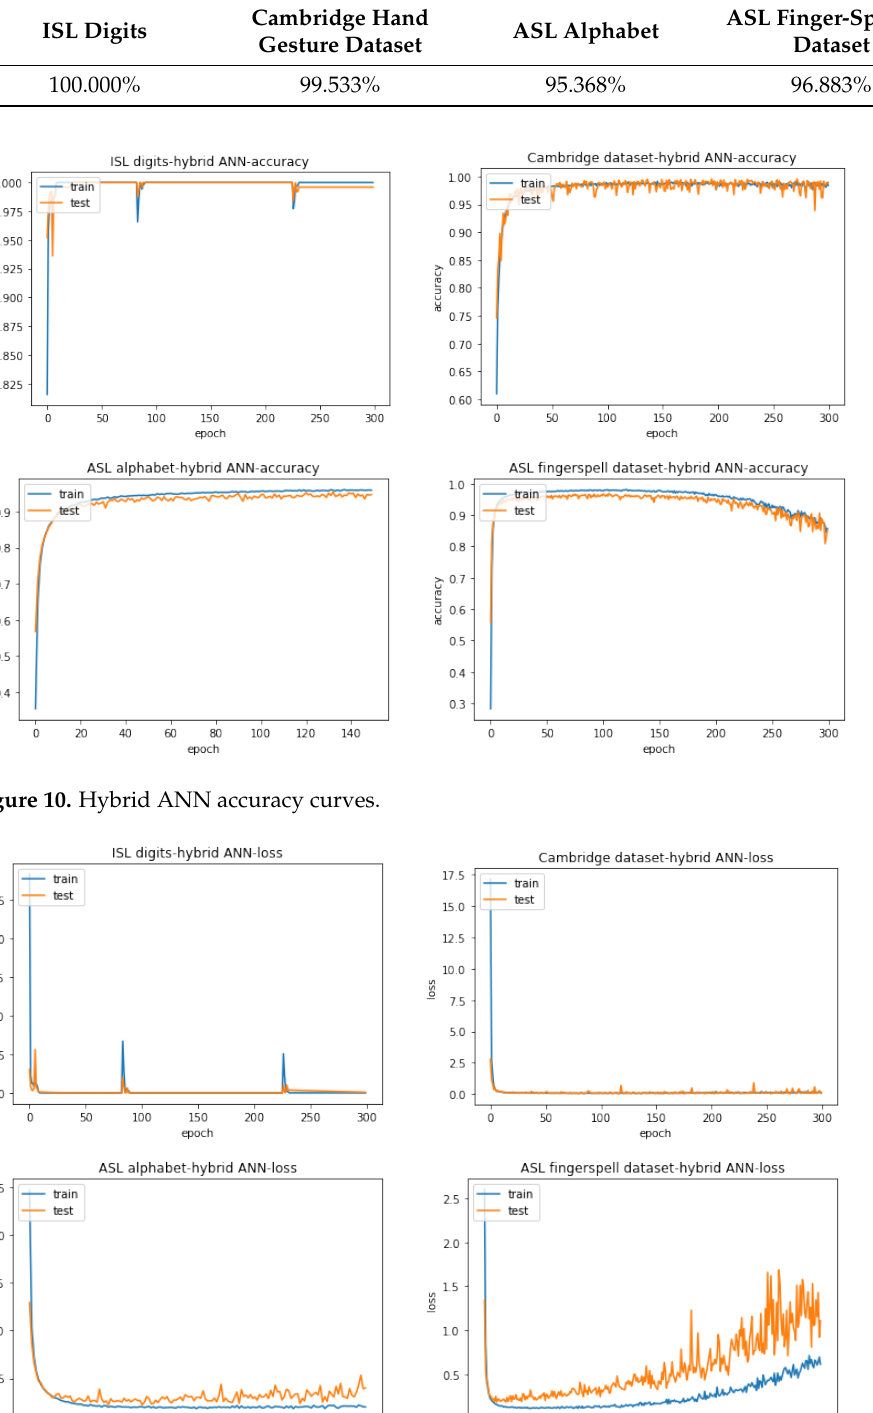
Table 11. Hybrid ANN accuracies.